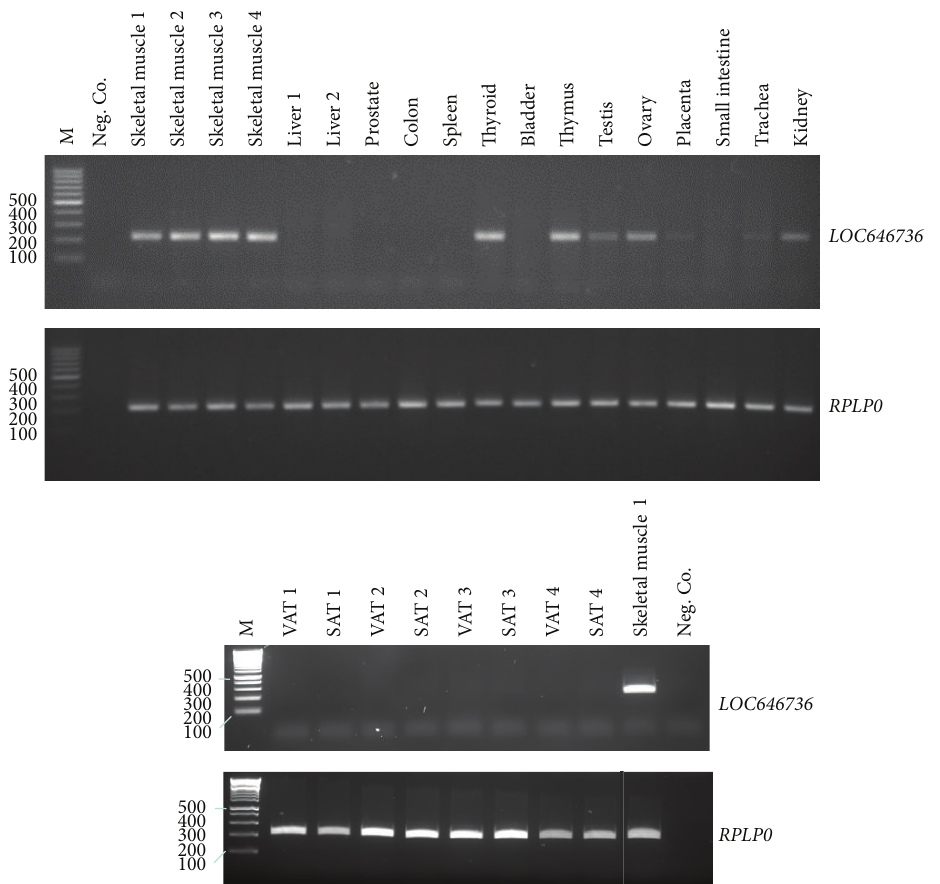
Figure 3: Tissue-specific expression of LOC646736 transcripts using cDNA obtained from tissues indicated on top and primers targeting exons 6 and 7 and from visceral (VAT) or subcutaneous (SAT) adipose tissues of four obese subjects in comparison to skeletal muscle. RPLP0 transcript abundance in the respective tissues is shown below for comparison. M, DNA marker; Neg. Co., negative control.